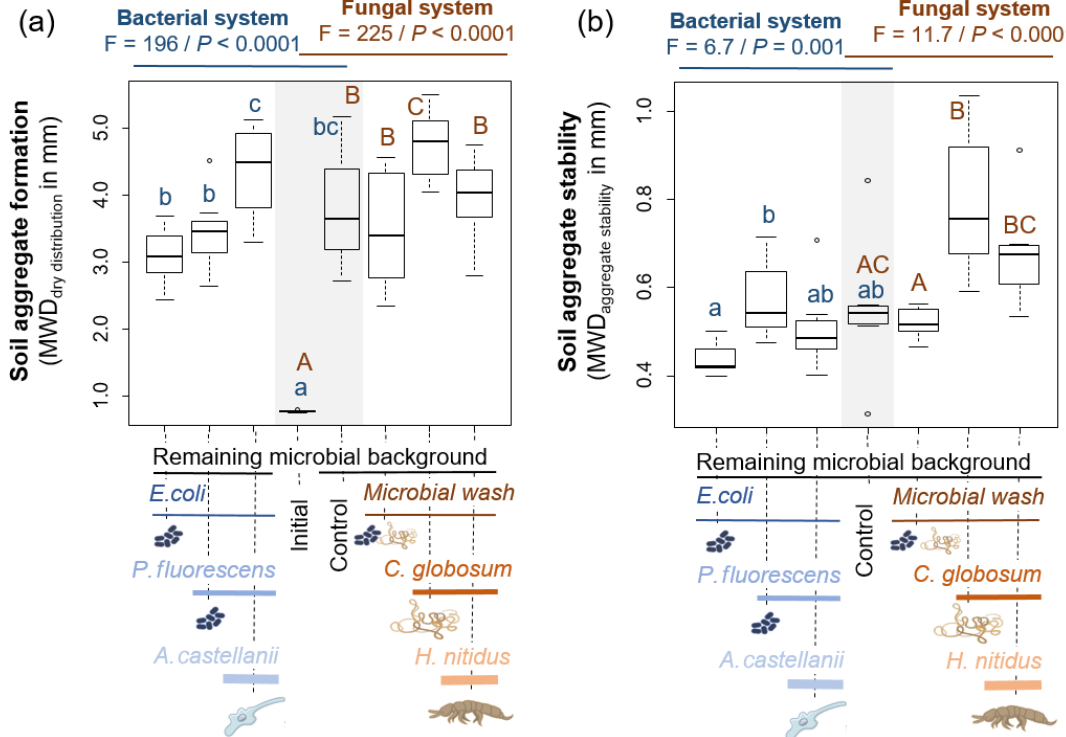
Figure 4. Effect of bacterial and fungal consumer–prey inoculations on (a) soil aggregate formation and (b) soil aggregate stability. Differ- ences between treatments were analysed separately for the bacterial and fungal systems using GLS models followed by ANOVA and post hoc Tukey tests. Letters (blue lowercase for bacterial system and brown capital for fungal system) indicate significant differences between means according to Tukey tests. Grey background indicates control treatments common to bacterial and fungal systems. ∗∗∗ P< 0 . 001; ∗∗ P< 0 .